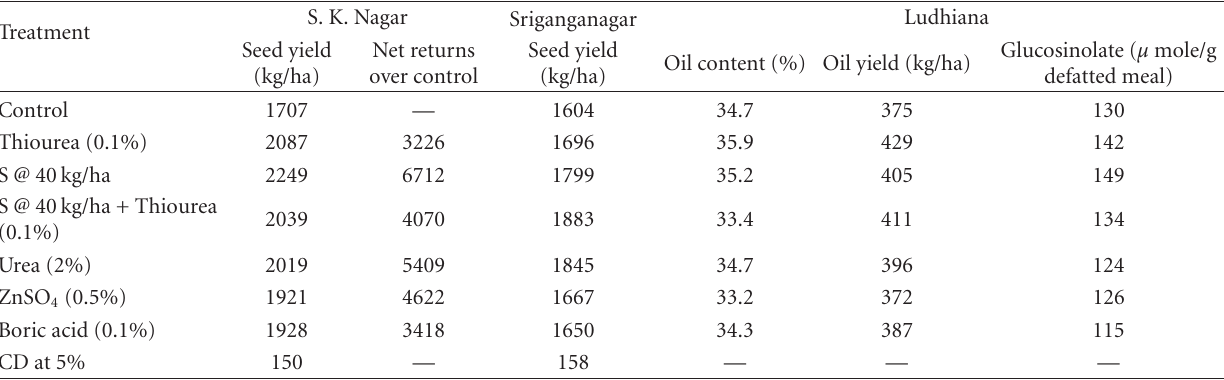
Table 12: Seed yield (kg/ha) and net returns (Rs./ha) of mustard as influenced by foliar application of agrochemicals at di ff erent locations. Treatment Control